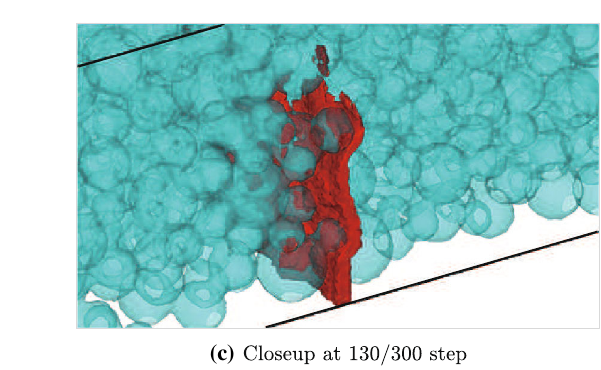
Fig. 12 Distribution of damage: 3D crack propagation behavior in highly heterogeneous solid